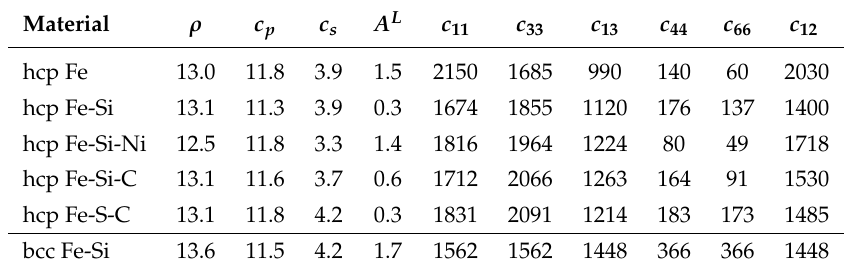
Table 1. The elastic constants and seismic wave speeds of iron alloys (column 1; [17–21]). The alloy’s density in g/cm 3 ( ρ ; column 2), seismic compressional wave speed in km/s ( c p ; column 3), shear wave speed in km/s ( c s ; column 4), the strength of anisotropy ( A L ; column 6; [22]), and the elastic tensor elements in GPa (columns 6 through 11) are